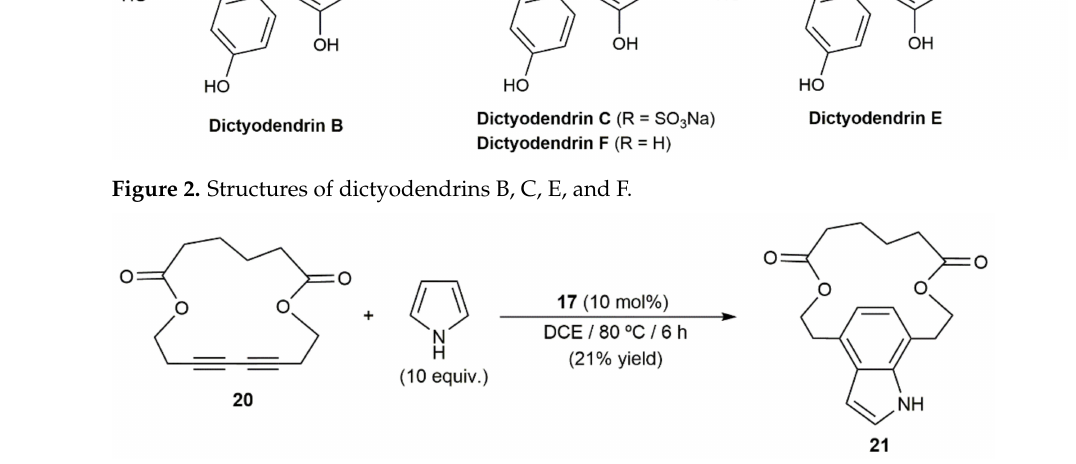
Scheme 11. Gold(I)-catalyzed synthesis of the para -indolophane derivative 21